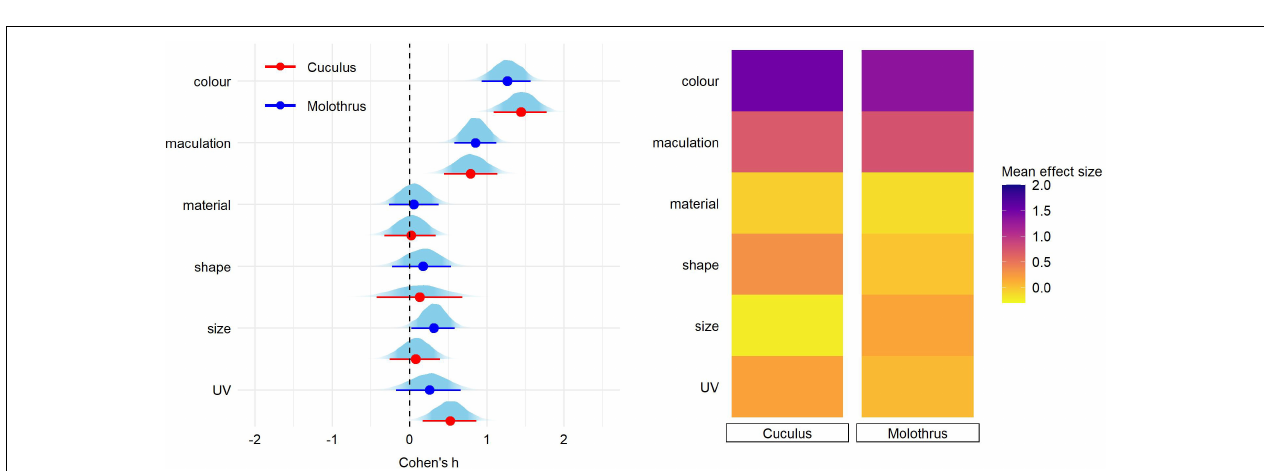
FIGURE 3 | Predicted effect size for egg trait types according to the breeding strategy (nest type: open or closed). On the left, for each trait type we show the parameter distribution with its median (dot) and 89% credible interval (lines). On the right, the median effect sizes are plotted as a heatmap for each trait type separated by host nest architecture.